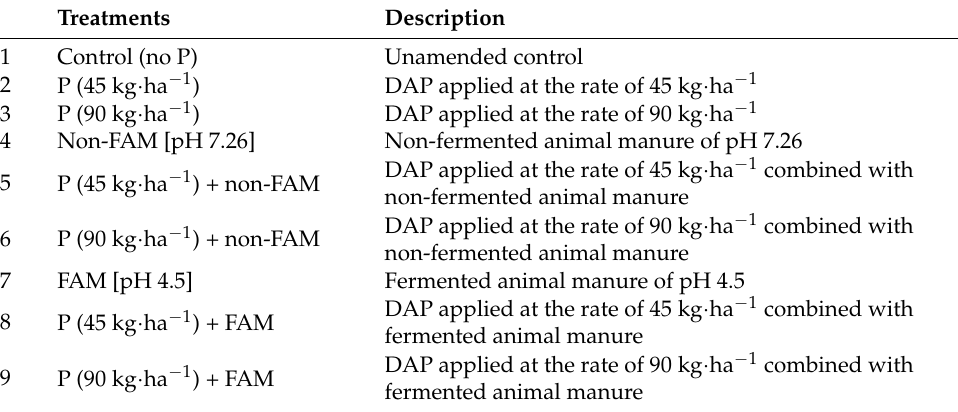
Table 1. The treatment description applied in the pot experiment.